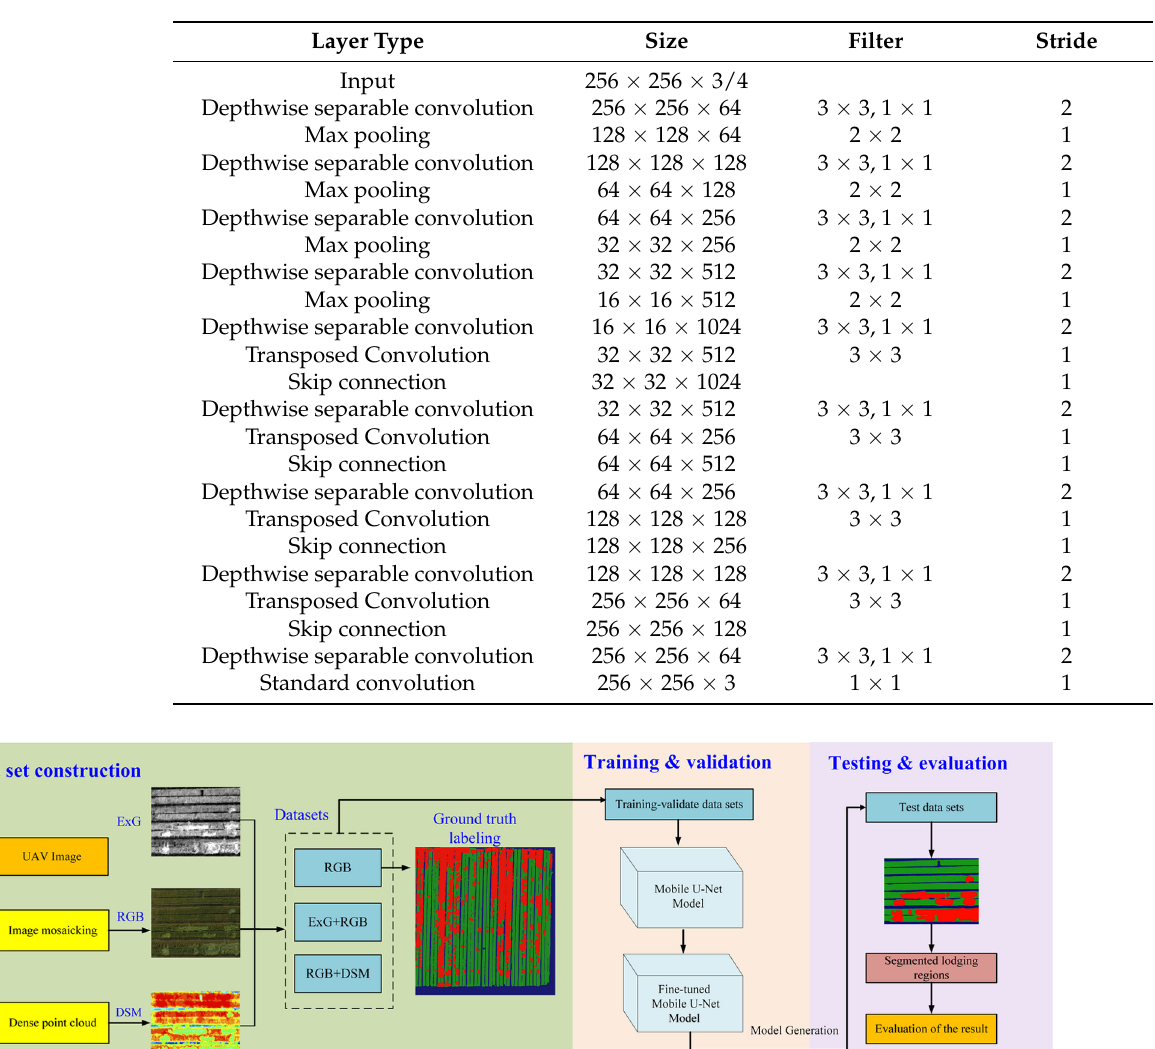
Table 1. Parameters of the Mobile U-Net model.